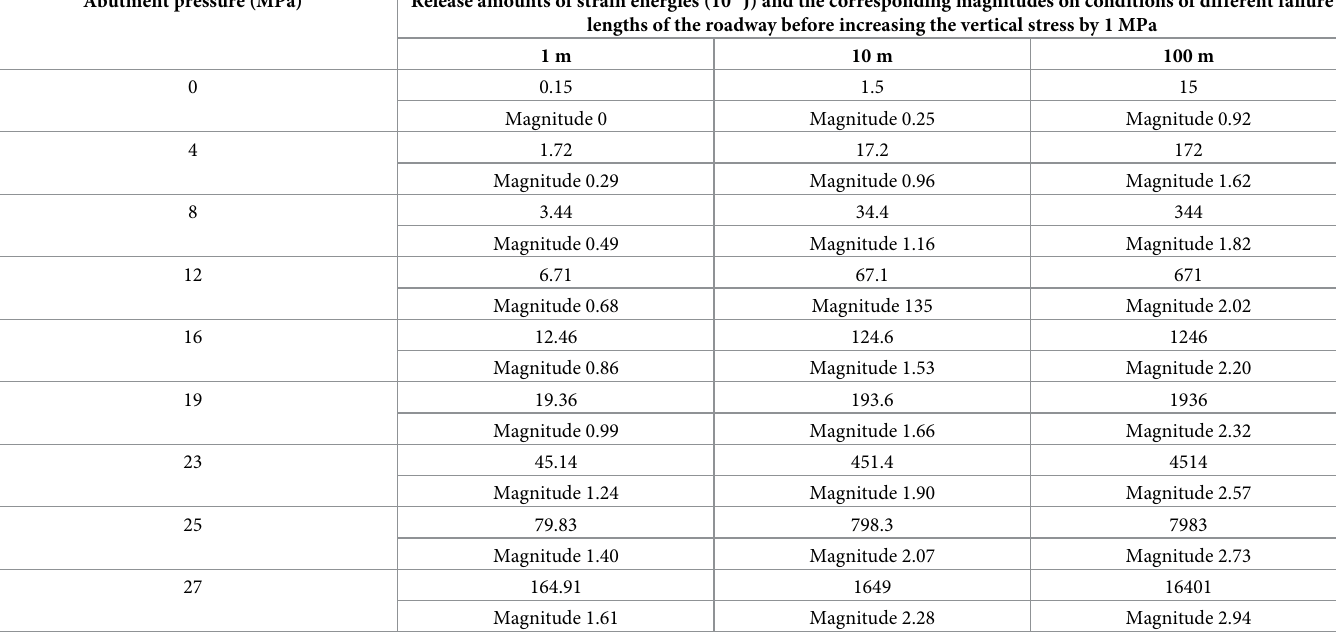
Table 3. Changes in strain energy after separately increasing the vertical stress by 1 MPa under different abutment pressures. Abutment pressure (MPa)